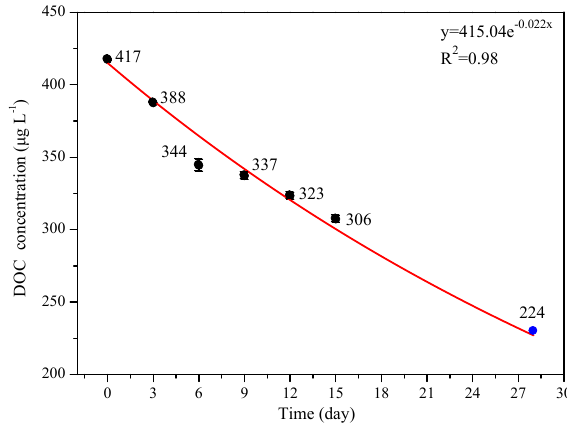
Figure 4. Exponential deceases in DOC concentrations during the biodegradation experiment. The blue point is calculated using equa- tions derived from the experimental data (black